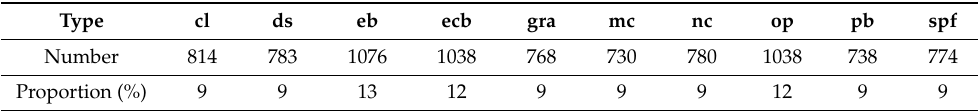
Table 2. The number of defect images in the augmented dataset.